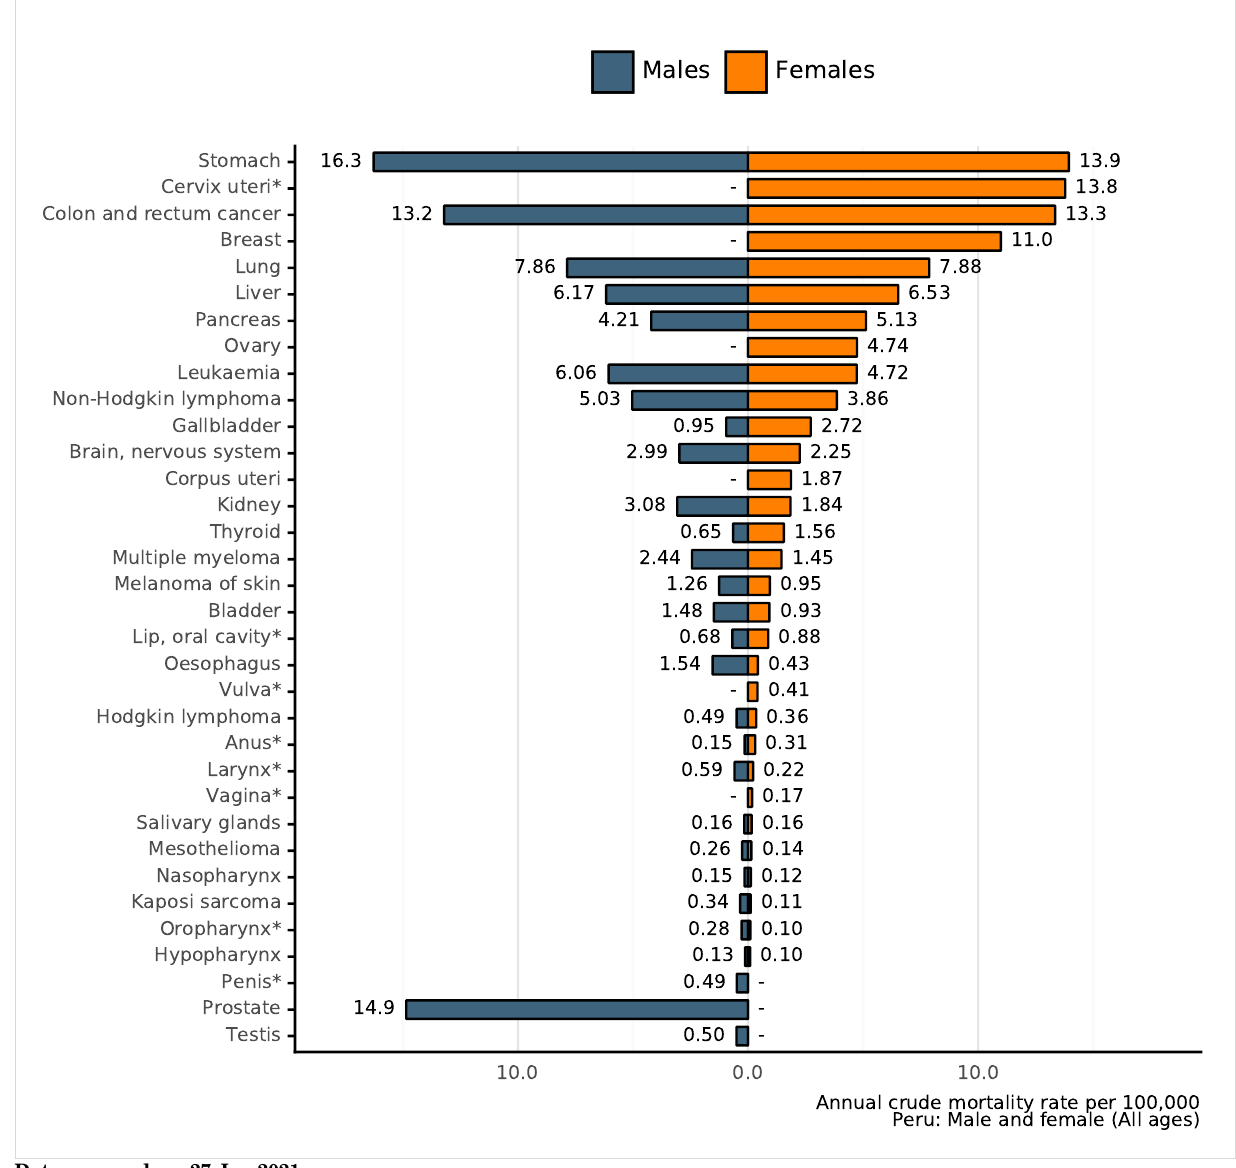
Annual crude mortality rate per 100,000 Peru: Male and female (All